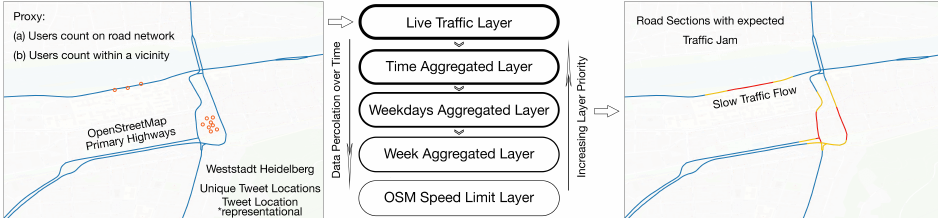
Figure 1. Conceptual layers contributing to the whole SM2T infrastructure. They are stacked in increasing order of priority. The Live Traffic layer is generated using two identified Twitter proxies, along with the land-use land-cover POI and betweenness centrality (cf. main text). Note that on the left map only Twitter proxies are shown.